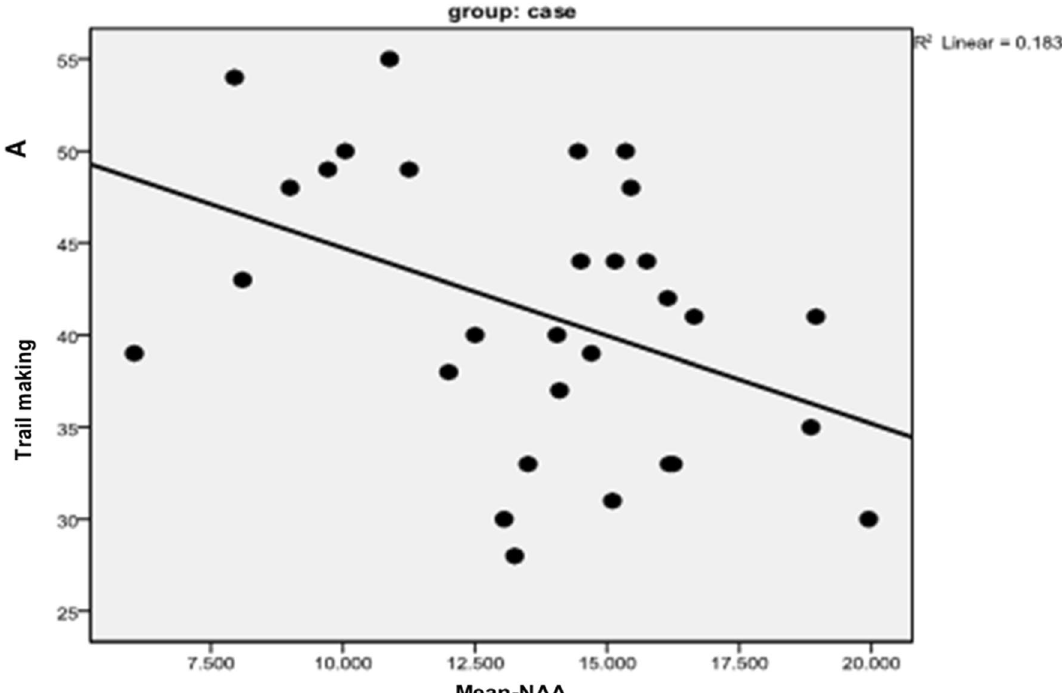
Fig. 3 Correlation between mean‑NAA level and trail making A test among the epileptic patient group. NAA N ‑acetyl